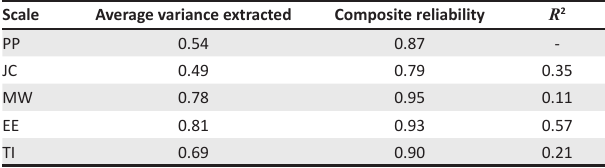
TABLE 4: Analysis of the partial least squares path model. Scale Average variance extracted Composite